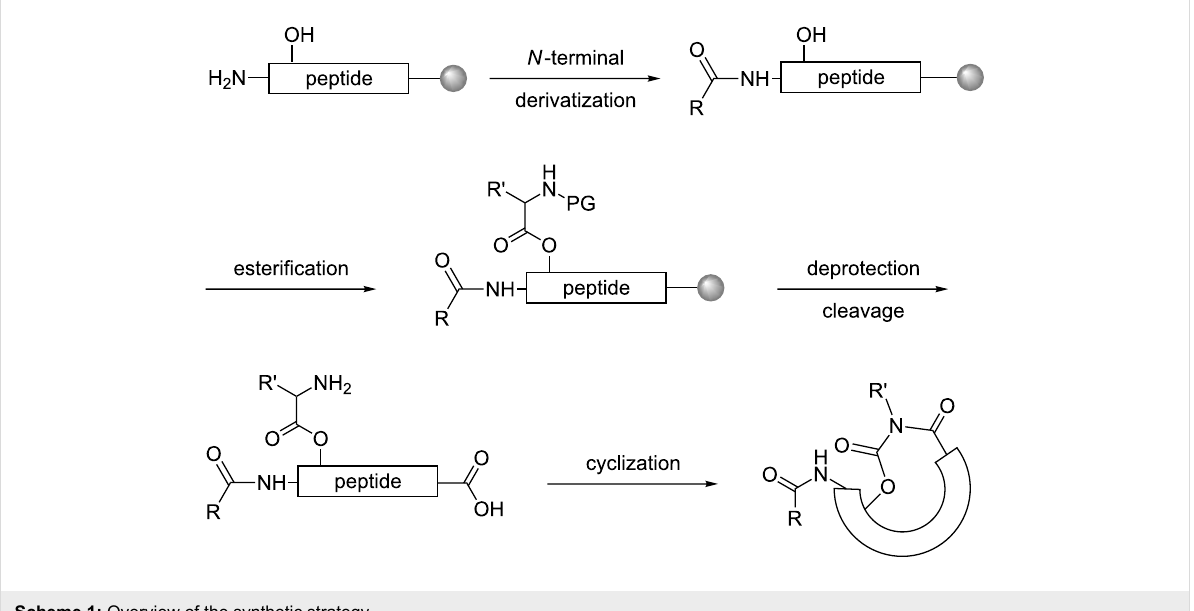
Scheme 1: Overview of the synthetic strategy.